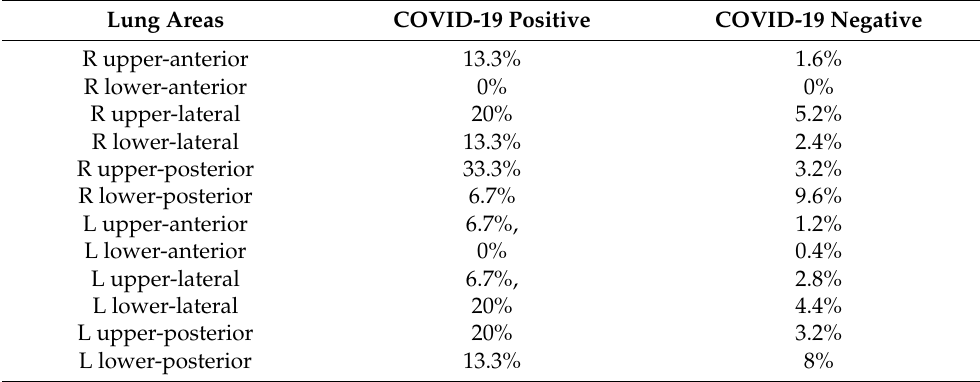
Table 3. Individual lung areas involvement in COVID-19 positive and negative subjects. R = right, L =